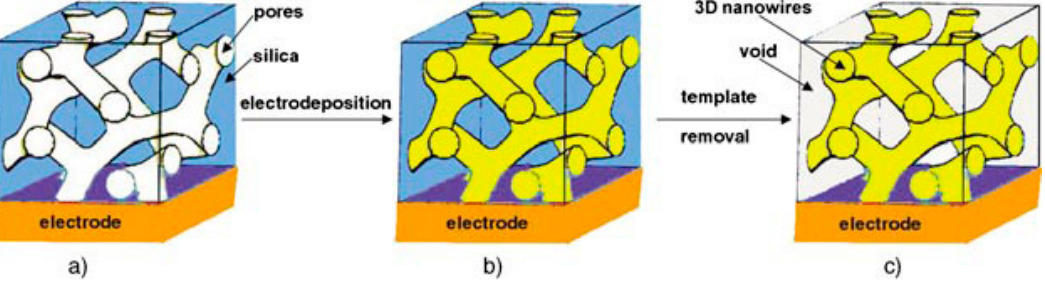
Figure 1. Schematic showing the formation of 3D continuous macroscopic metal or semiconductor nanowire networks by a templated electrodeposition technique. ( A ) 3D cubic mesoporous template, ( B ) 3D nanowire/silica nanocomposites, ( C ) 3D nanowire network. Images reproduced from Ref. [8] with permission.